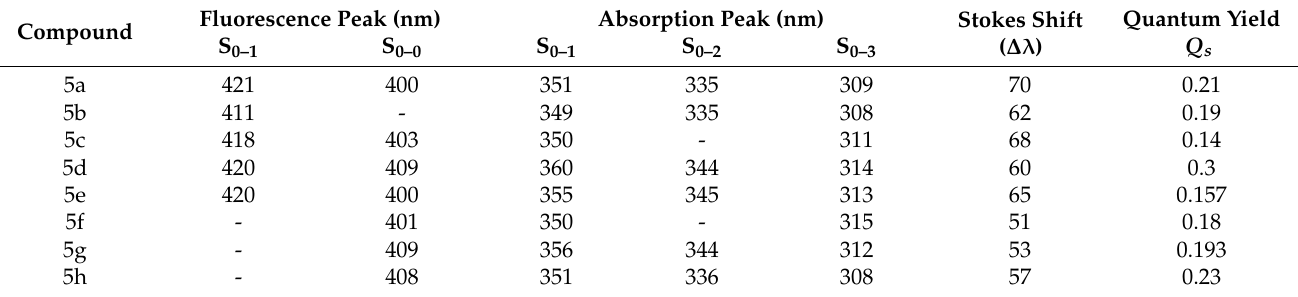
Figure 5. ( i , ii ) the absorption spectra of 5a – d and 5e – h, respectively; ( iii , iv ) the fluorescence spectra of 5a – d and 5e – h , respectively. Table 1. Measured fluorescence and absorption peak, along with calculated Stokes shift and quantum yield of synthesized compounds 5a – h .